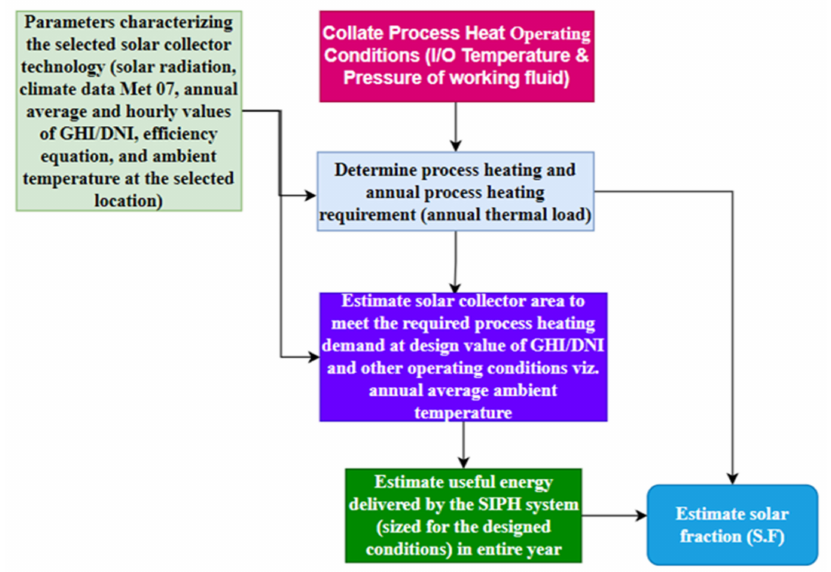
Figure 3. A schematic of the methodology adopted for performance estimation of SIPH